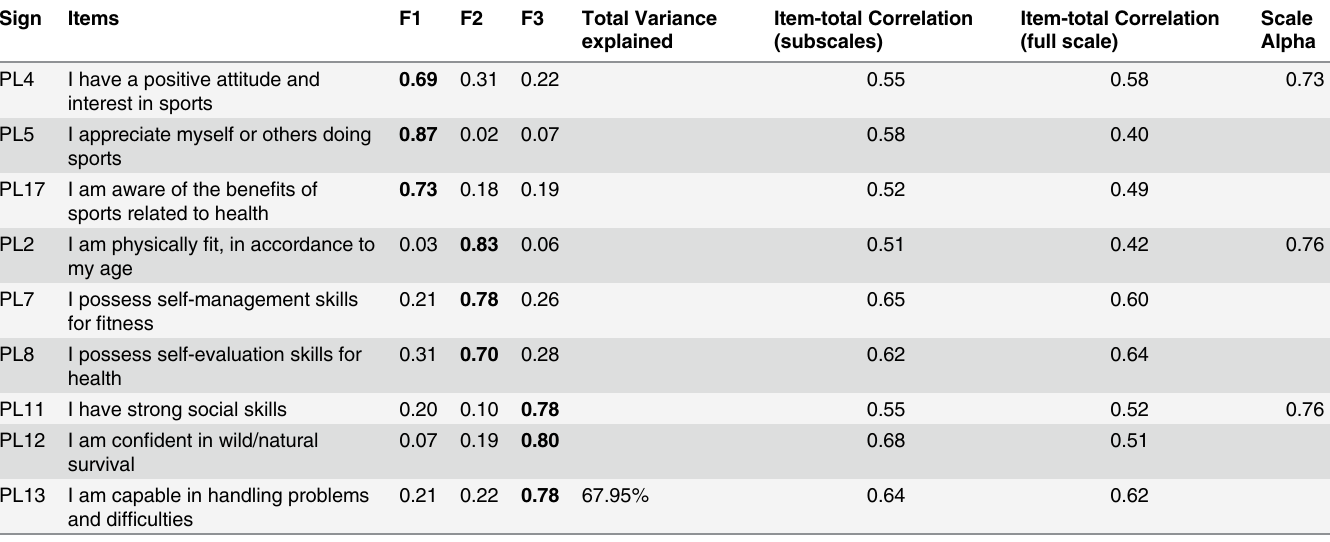
Table 2. Factor structures by Exploratory Factor Analysis and Reliability (N =